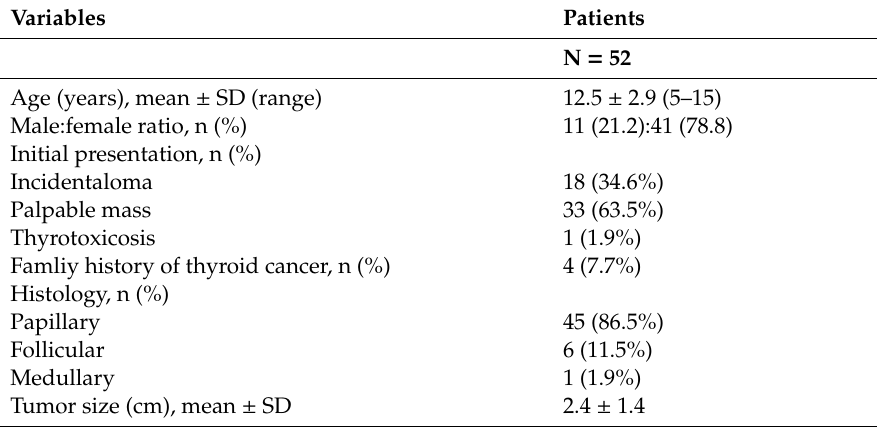
Table 1. Clinical and pathological characteristics of thyroid carcinoma in 52 patients aged 15 years old and less at diagnosis. SD, standard